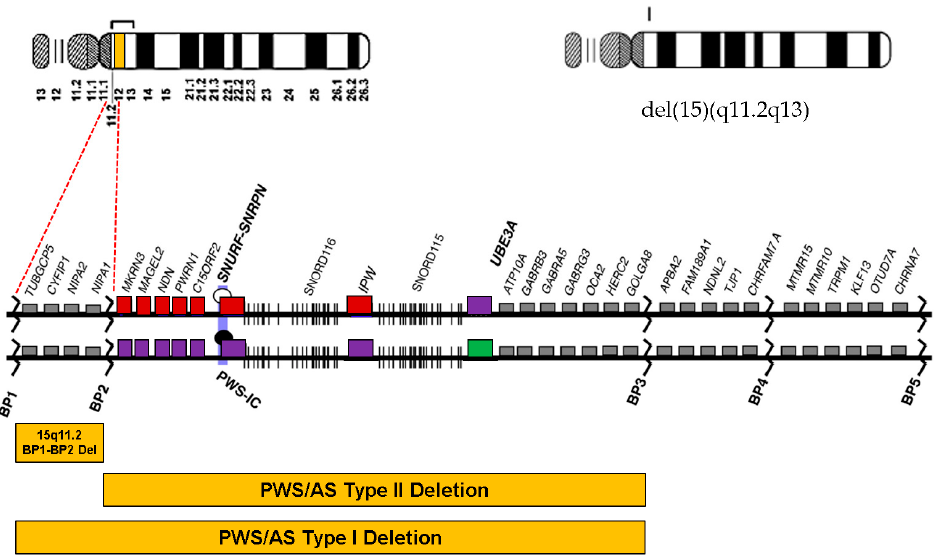
Figure 3. Map of the 15q11.2-q13 region demonstrates gene distribution between breakpoint (BP) 1 and BP5 on the proximal 15q11.2 region. The 15q11.2 deletion region is located between BP1 and BP2. Genes displayed in red and green boxes are imprinted and expressed from the paternal and maternal alleles, respectively. Violet boxes indicate the silenced alleles. Gray boxes mark genes expressed from both parental alleles. Del, deletion; AS, Angelman syndrome; BP, breakpoint; PWS, Prader–Willi syndrome; IC, imprinting center.